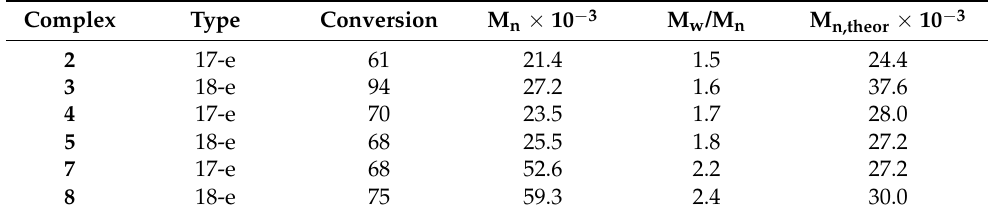
Table 3. The results of experiments on MMA polymerization in the presence of novel